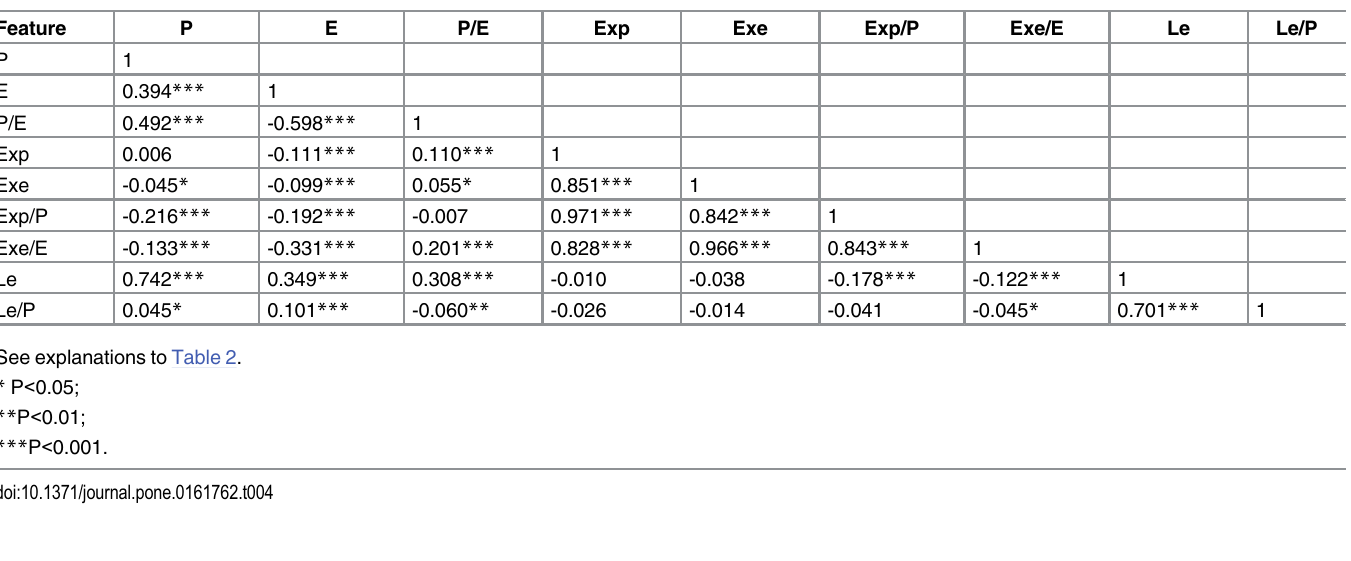
doi:10.1371/journal.pone.0161762.g004